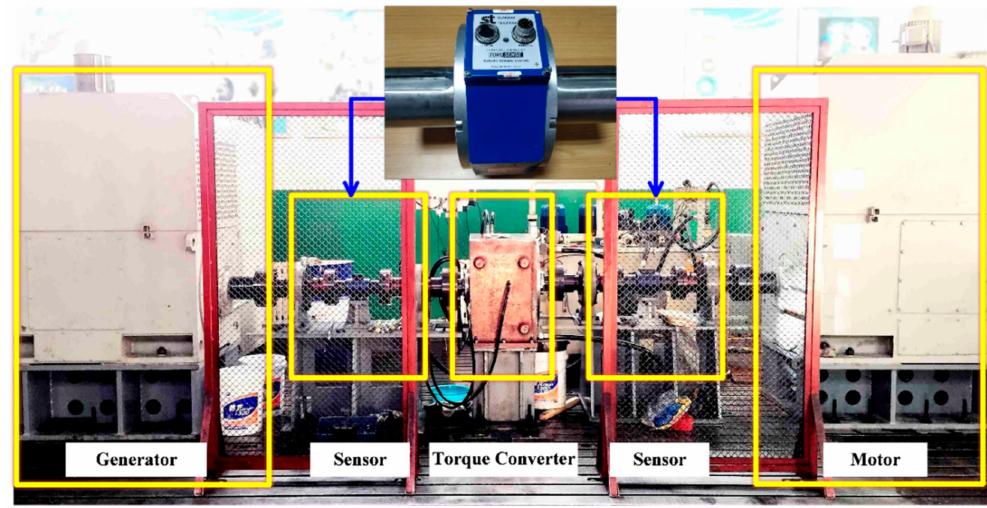
Figure 5. Torque converter test cell and its